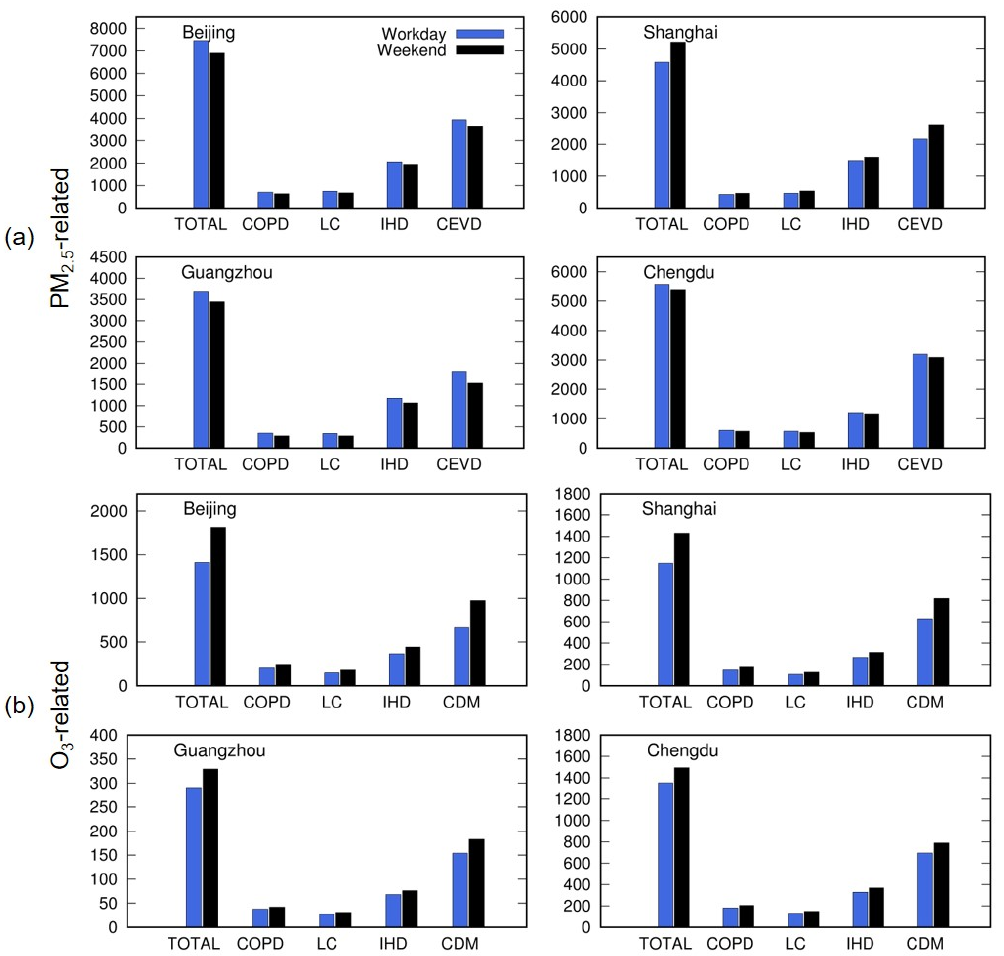
Figure 6. The annual premature mortality rate from COPD, LC, IHD, CDM and CEVD of CASE 2 in Beijing, Shanghai, Guangzhou and Chengdu. Panel (a) is PM 2 . 5 -related and (b) is O 3